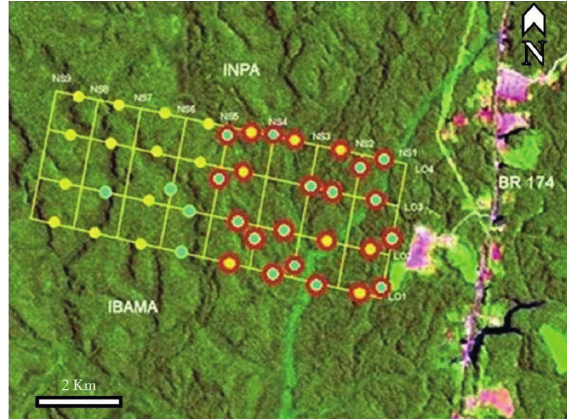
Figure 1 - RAPelD sampling grid located in the municipality of Manaus, Brazil. green markers represent riparian plots and yellow plots represent non-riparian plots. Plots sampled in the present study are circled in